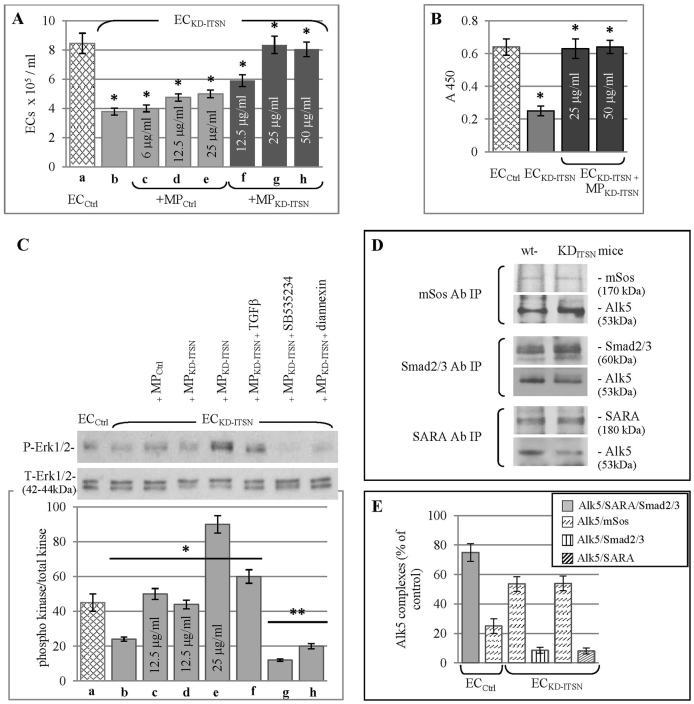
MPKD-ITSN–ECKD-ITSN interaction restores Erk1/2MAPK pro-survival signaling despite ITSN-1s deficiency. (A) ECCtrl (a) and ECKD-ITSN (b–h) were exposed to either MPCtrl (c–e) or MPKD-ITSN (f–h), as indicated. At 3 days post microparticle exposure, endothelial cells (ECs) were counted and the results expressed as cell number/ml. Data are normalized to day 3 ECCtrl. Values are shown as the mean±s.e.m. n = 3; *P<0.05. (B) BrdU incorporation in ECKD-ITSN exposed to MPKD-ITSN compared to ECKD-ITSN without microparticle treatment. Data are normalized to ECCtrl; values are shown as the mean±s.e.m. n = 3; *P<0.05. (C) Treatment of ECKD-ITSN with 25 µg/ml MPKD-ITSN increases Erk1/2 phosphorylation (e), by reference to ECCtrl (a) and ECKD-ITSN (b). MPCtrl and MPKD-ITSN (12.5 µg/ml) do not significantly activate Erk1/2MAPK (c,d). Exposure of ECKD-ITSN to 10 nM TGFβ for 30 min causes a moderate decrease in Erk1/2 phosphorylation (f), whereas pre-incubation of microparticles with 2 µM/l SB525334 (g) and 2 µM diannexin (h) abolished Erk1/2 activation. Note that frozen microparticles activate Erk1/2 similarly to fresh microparticles. The ratios of phospho (P)-Erk1/2:total (T)-Erk1/2 are shown as the mean±s.e.m.; n = 3. *P<0.05; **P<0.01 versus ECCtrl. (D) ITSN-1s deficiency alters the Smad2/3-Erk1/2MAPK signaling balance towards persistent Ras–Erk1/2MAPK activation. ECKD-ITSN lysates were subjected to immunoprecipitation (IP) with mSos, Smad2/3 and SARA antibodies (Ab). The immunoprecipitates were subjected to SDS-PAGE, electrotransferred to nitrocellulose membranes and blotted with antibodies against Alk5, mSos, Smad2/3 and SARA. wt, wild-type. (E) Densitometry of Alk5 levels in Alk5–SARA–Smad2 and Alk5–mSos complexes, considering that ECKD-ITSN show 40% lower Alk5 levels. Data are representative of three experiments performed under identical experimental conditions [500 µg of total protein, 2 µg of each immunoprecipitating antibody, 1∶1000 dilution for secondary antibodies (for Smad2/3 and SARA immunoprecipitaion) and 1∶500 dilution (for mSos immunoprecipitation) and identical ECL exposure time]. The data show the mean±s.e.m.; *P<0.05, versus corresponding ECCtrl values.